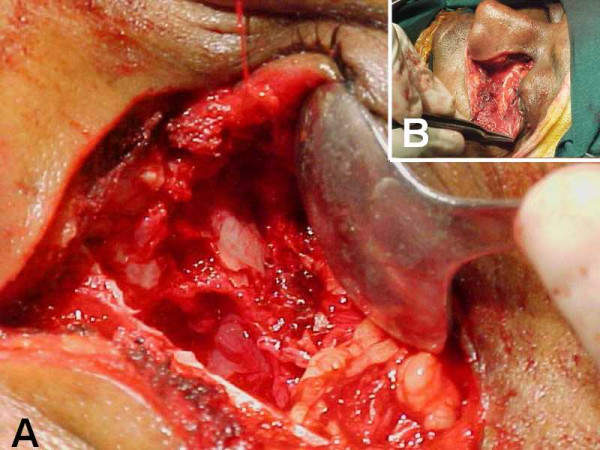
Facial approach Weber Ferguson incision (B) followed by inferior orbitotomy (A) which enabled the retraction of the eyeball.